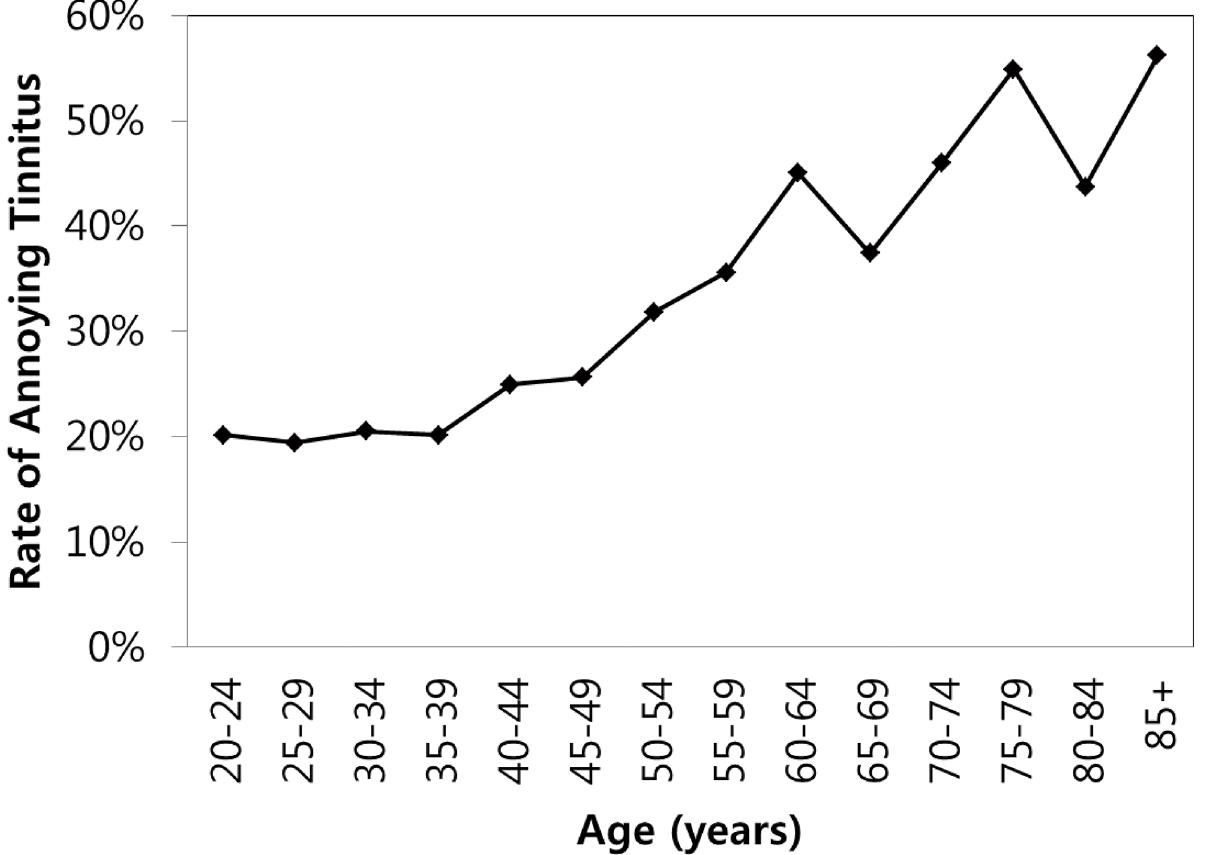
Fig 2. Rates of annoying tinnitus in the Korean adult